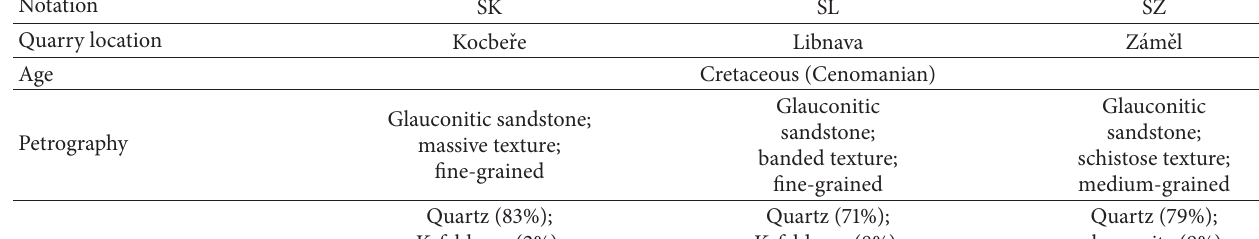
Table 1: Overview of studied sandstones.